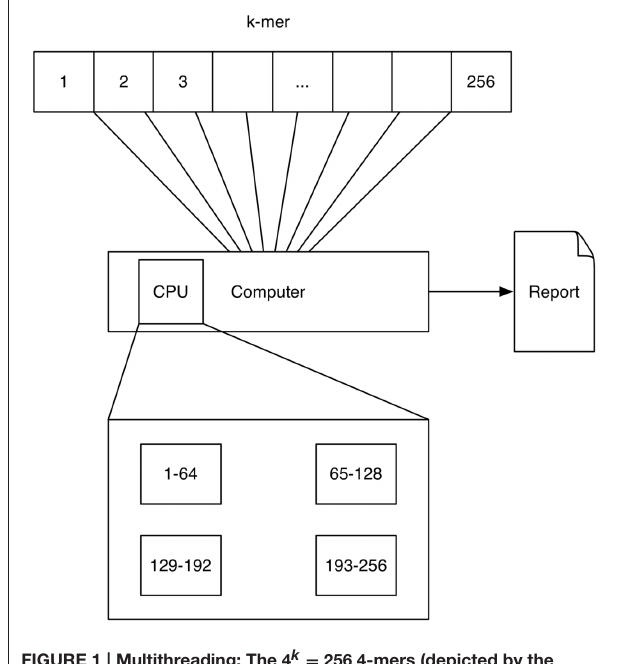
FIGURE 1 | Multithreading: The 4 k = 256 4 -mers (depicted by the numbers 1–256) are processed on a single computer with four processors (depicted by the rectangular boxes at the bottom). Each processor computes a quarter of all k -mer